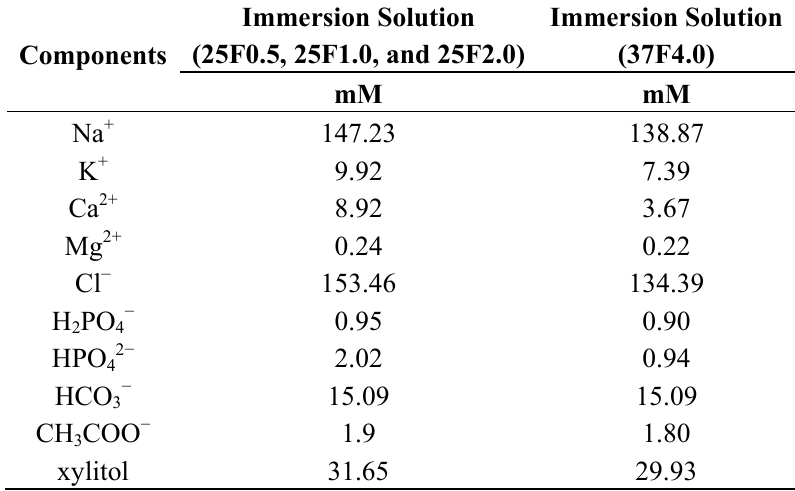
Table 1. Chemical compositions of the supersaturated CaP solutions used to prepare the 25F0.5, 25F1.0, 25F2.0, and 37F4.0 group